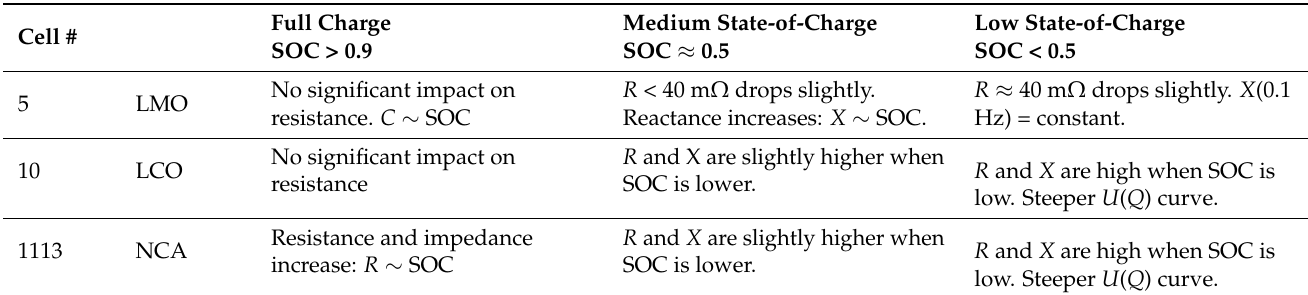
Table 3. Qualitative changes in the impedance spectrum in different state-of-charge areas: R resistance of the high-frequency arc, X reactance at 0.1 Hz, C capacitance at 0.1 Hz.